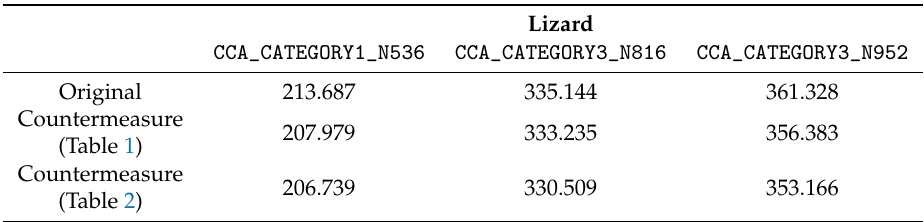
Table 3. Comparison of the running time of key generation stage of the original cryptosystem verses countermeasure-implemented cryptosystem represented in